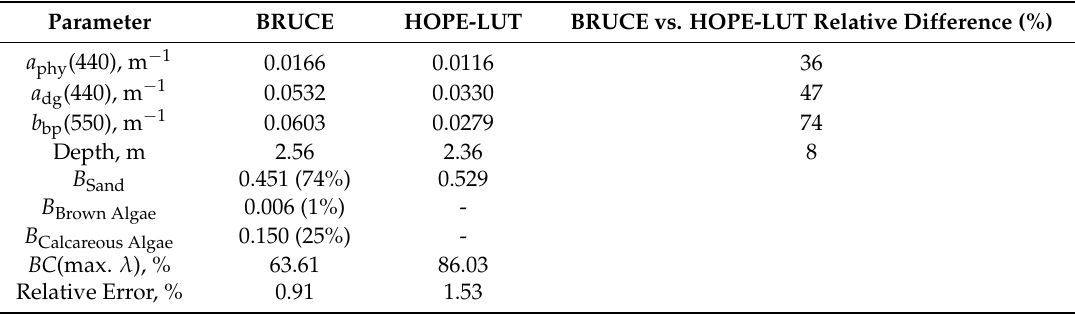
Table 7. The retrieved IOPs, depth, bottom albedo and relative cost function over a homogeneous sand pixel in the PRISM image of Heron Reef. For BRUCE, the benthic endmember combination of Sand, Brown Algae and Calcareous Algae generated the lowest cost-function of this pixel. The percentages in brackets next to the bottom albedo values represent the relative contribution to the bottom brightness at 550 nm. The unbiased relative difference was used to compare the retrievals from HOPE-LUT and BRUCE. BC (max. λ ) represents the percentage bottom contribution to the subsurface remote sensing reflectance at the wavelength that most penetrated the water